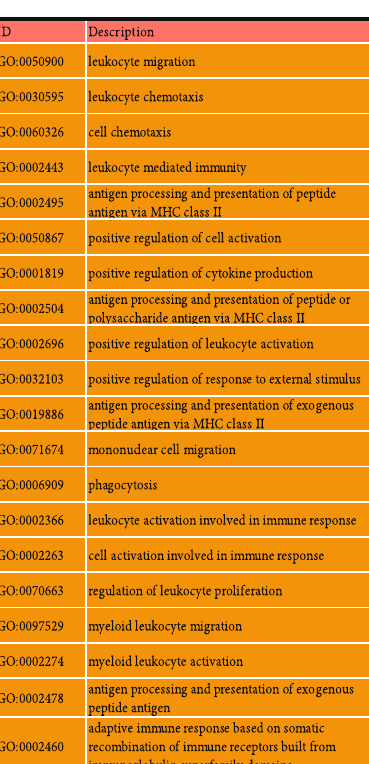
Figure 4: GO analysis of the DEGs in di ff erent biological processes. Lap 1 indicates the top 20 GO terms, while the number of genes is listed in the outer lap. Lap 2 shows the number of background genes in the human genome as well as P values for DEG enrichment for certain biological processes. Lap 3 presents the number of genes that are enriched in this process. Lap 4 denotes the enrichment factor for each GO term. GO: Gene